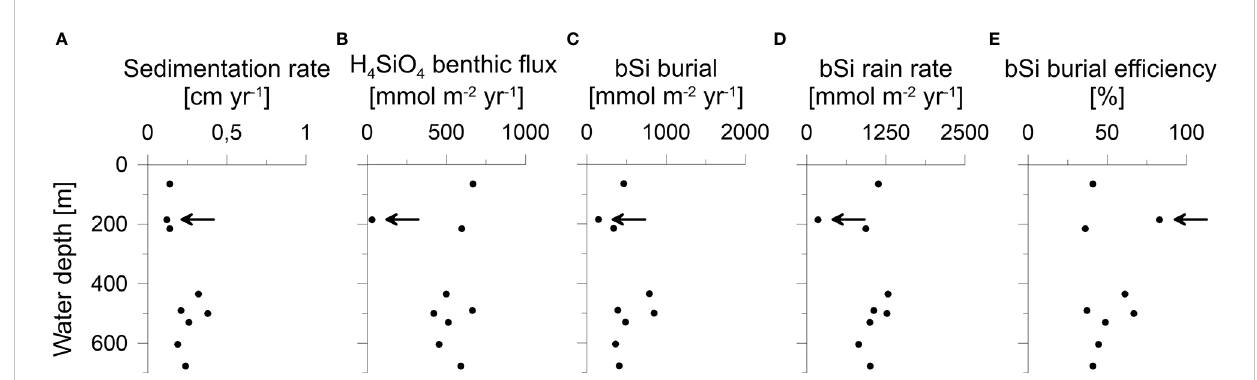
FIGURE 5 (A) Sedimentation rate, (B) H 4 SiO 4 benthic fl ux, (C) bSi burial fl ux, (D) bSi rain rate and (E) burial ef fi ciency plotted against water depth. Data at 185 m water depths correspond to the sandy station MUC6 (indicated by the